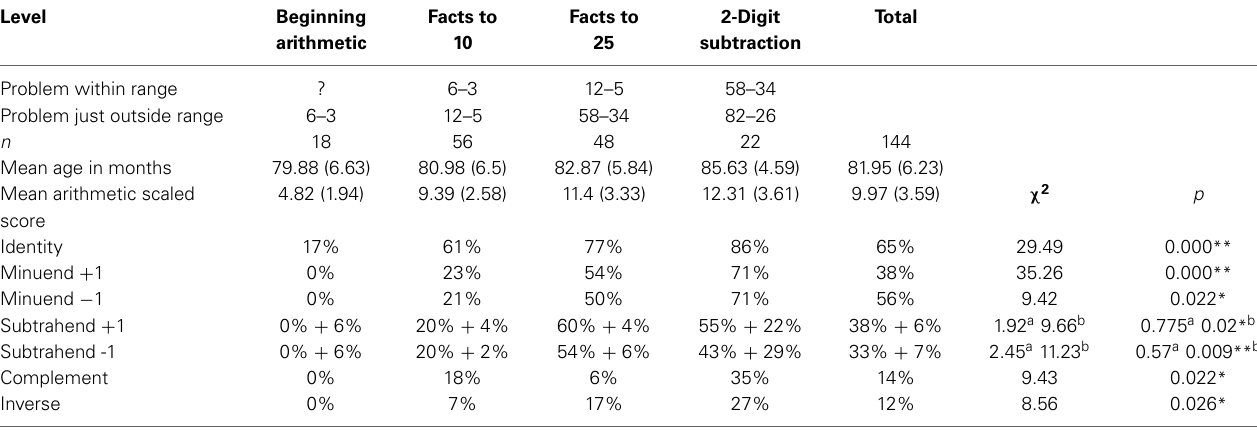
Table 3 | Subtraction strategies used at different